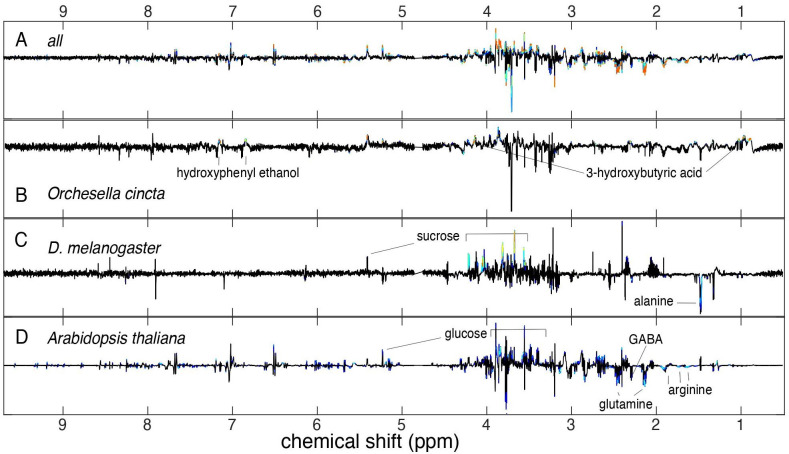
Metabolite loading spectra.Metabolite loading spectra showing significant (colored peaks, p < 0.05) up- or downregulated metabolites in individuals acclimated to fluctuating temperatures compared to constant temperature for A) layered spectrum for all organisms, B) O. cincta, C) D. melanogaster, and D) A. thaliana.